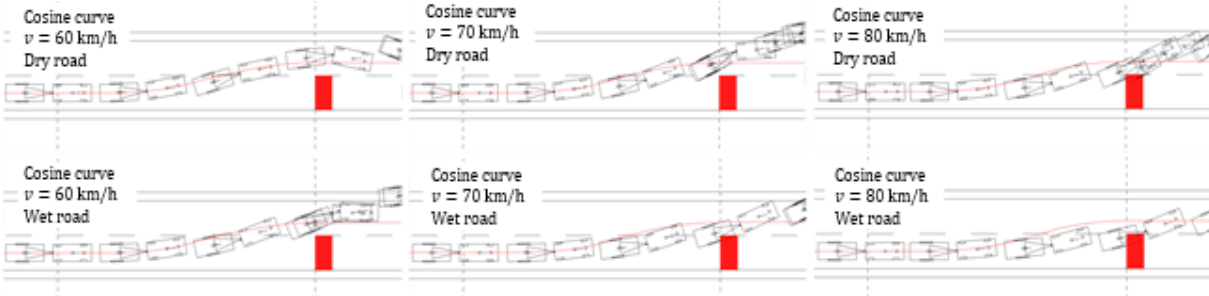
Figure 14. Comparison of animations of the CT unit’s motion for v = 60 km/h, 70 km/h and 80 km/h and for three y M ( x ) determination methods; dry road surface.